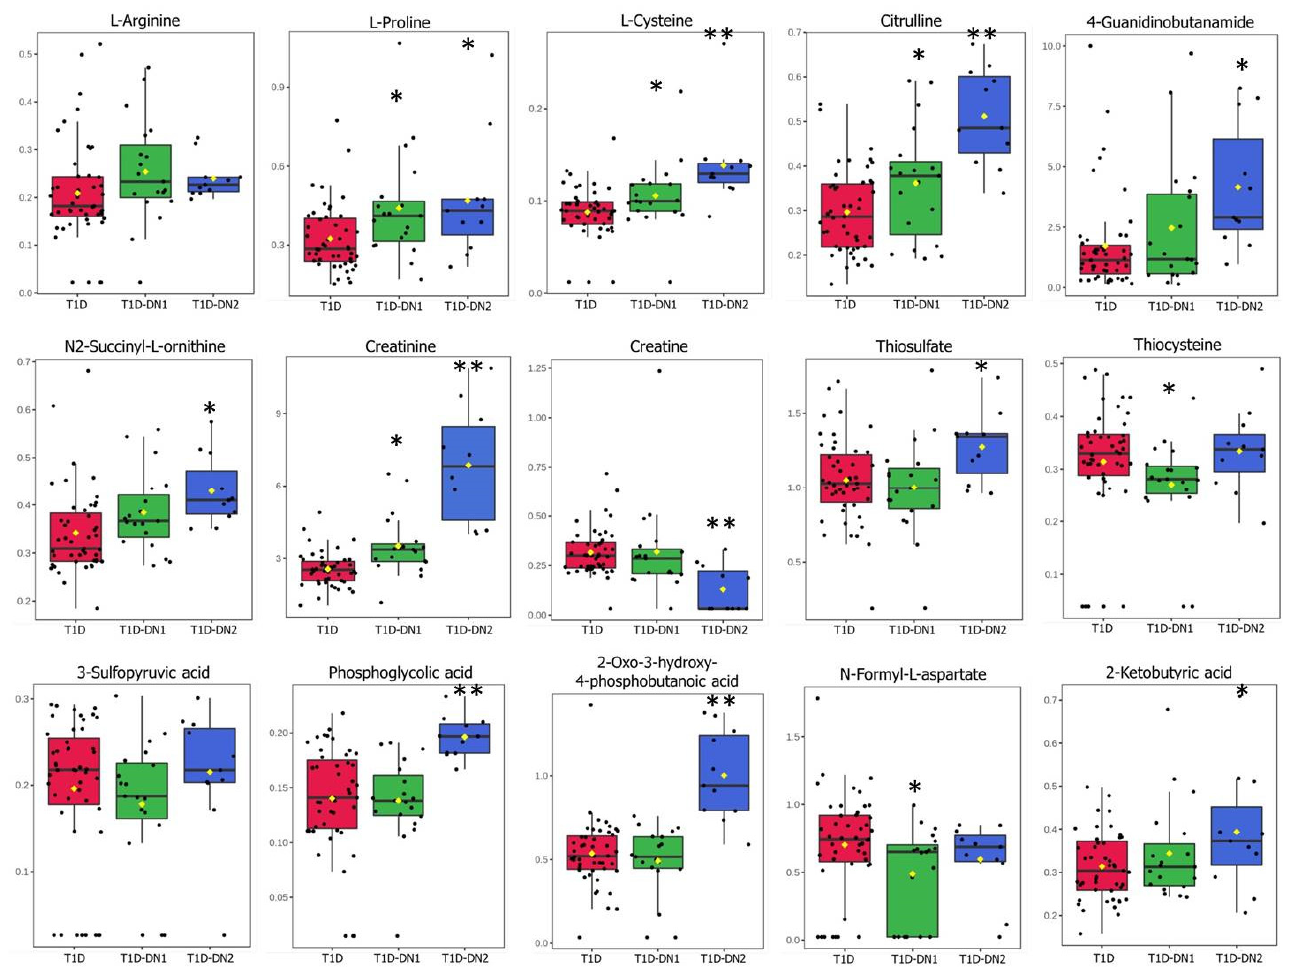
Figure 2. Box plots depicting abundance of the identified dysregulated metabolites in the blood plasma samples of the T1D (red), T1D-DN1 (green) and T1D-DN2 (blue) groups. Each dot represents individual blood plasma sample from each patients. * ‐ p ‐ value < 0.05; ** ‐ p ‐ value < 0.01.